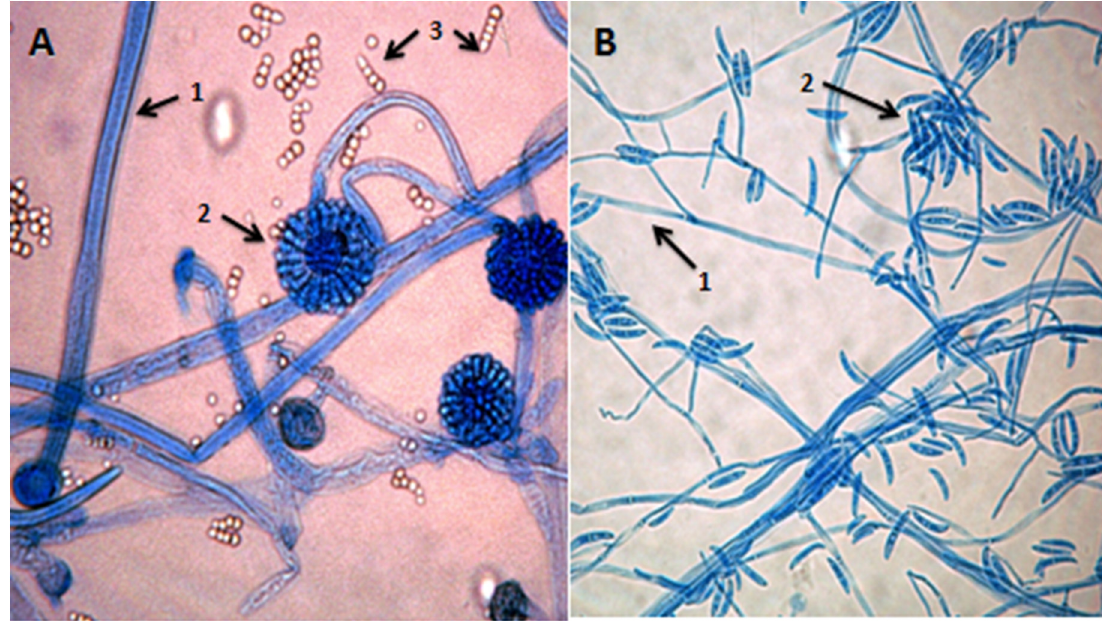
Figure 4. Microscopic examination of cultured fungi at 40× magnification (some of the fungus colony was picked up with adhesive tape, placed on clean glass slide and covered with a slip). ( A ): Microscopic image of Syncephalastrum spp. stained with lactophenol cotton blue: (1) broad, non-septate hyphaes, (2) sympodially branching sporangiophores with terminal vesicles bearing finger-like merosporangia directly over their entire surface, and (3) globose to ovoid, smooth-walled sporangiospores (merospores). ( B ): Microscopic image of Fusarium solani SC stained with lactophenol cotton blue: (1) hyaline hyphaes and (2) septate macroconidia slightly curved, hyaline and broad.